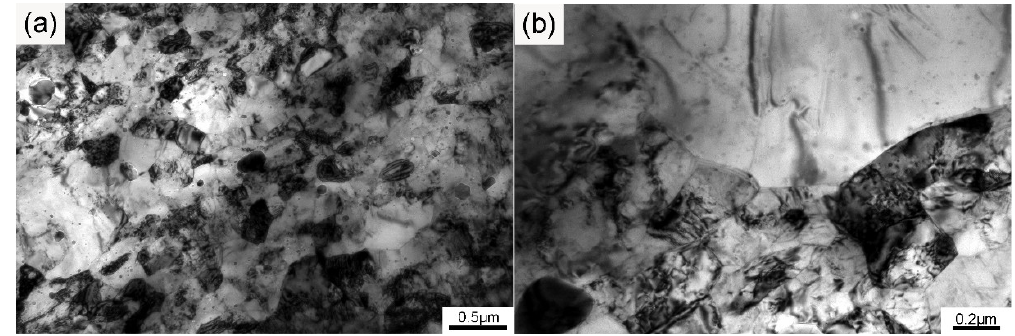
Figure 2. TEM graphs of the sample at ( a ) low and ( b ) high magnification.